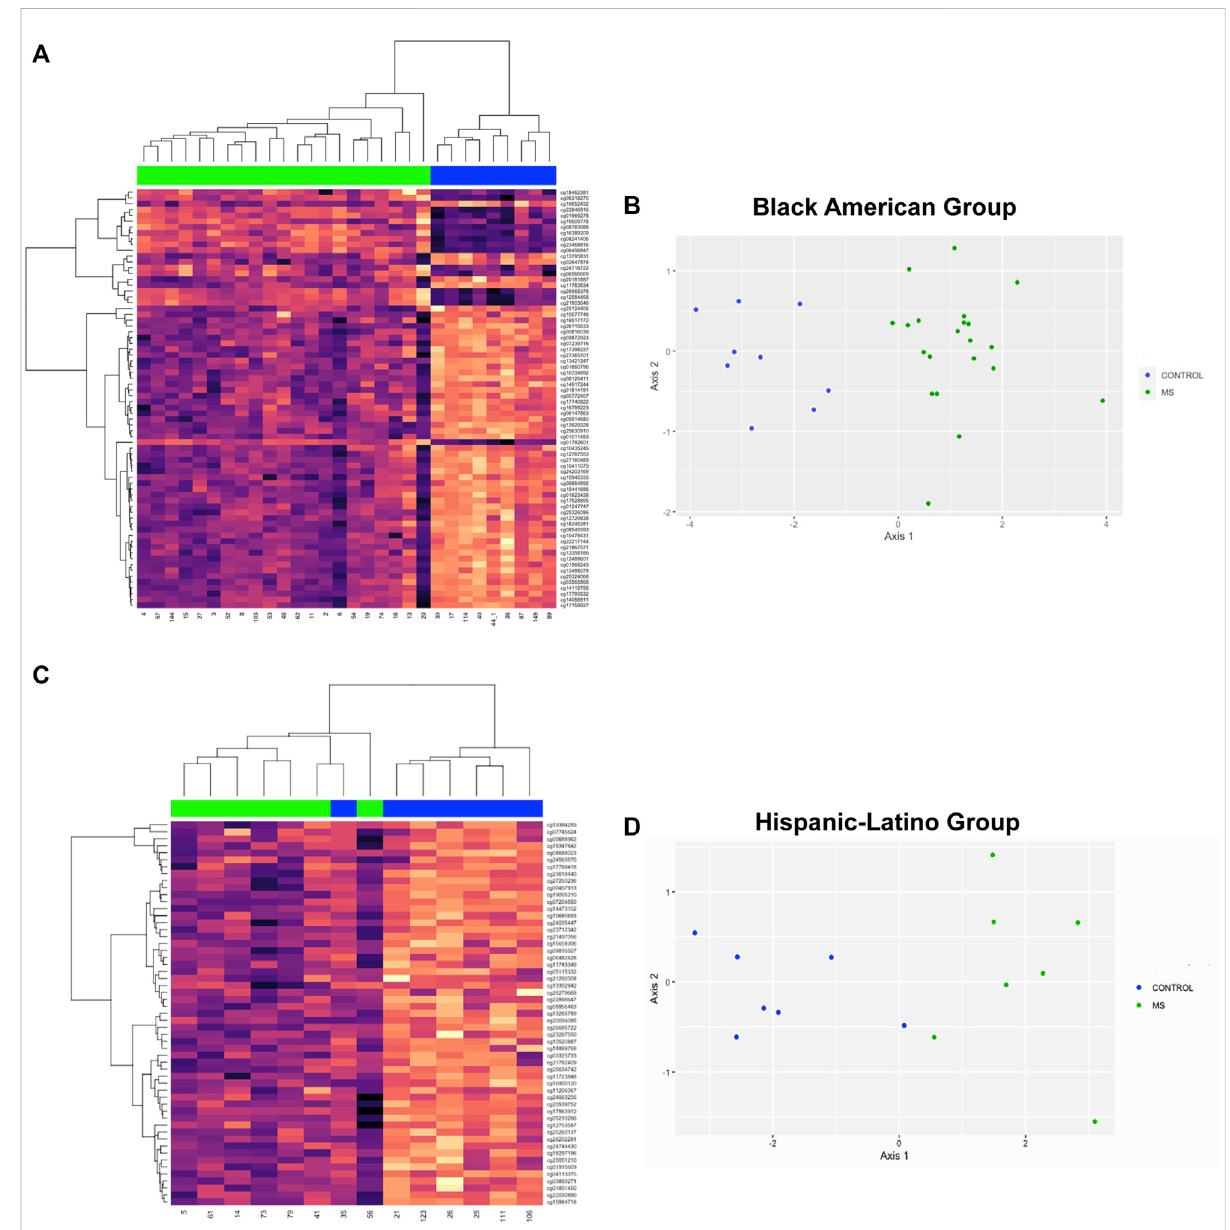
FIGURE 5 Hierarchal clustering and multi-dimensional scaling (MDS) analysis of differentially methylated regions associated with MS in racial and ethnic subgroups. (A) Thetop10DMR ’ sforthecomparisonofMS versus ControlsforBlackAmericansincluded6regionsthatwerepresentintheanalysisof all donors (ARID5B, CDK2AP1, CLU, CTSZ, RABGAP1, and TNFSF12-TNFSF-13) and 4 other regions that reached statistical signi fi cance in the analysis of all donors but that were not in the top 10 regions (DUSP6, FOXI2, GPX6, and SPI2). 72 DMP ’ s (Supplementary Table S19) within the top 10 DMR ’ s were used for hierachal cluster analysis. (B) MDS plot showed a GOF = 0.81. (C) In the Hispanic-Latino subgroup, the top 10 DMR ’ s were: HOXD8, HPS4, KCNIP4, mir124-2, PTCHD4, PHYHIPL, RAB32, TREML2, UNC5, and WBSCR17. 55 probes within the top 10 DMR ’ s were used